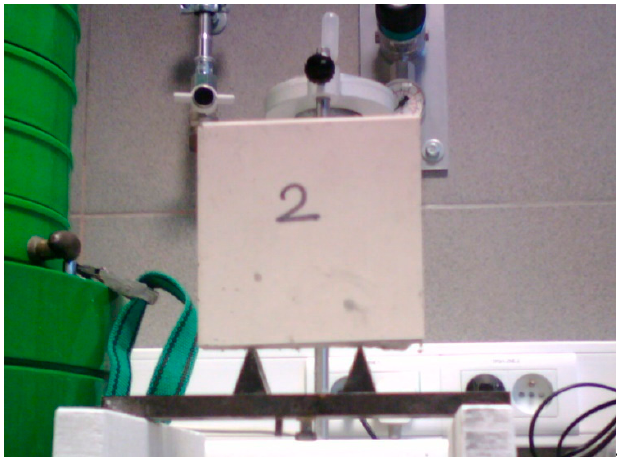
Figure 2. Sample during the thermal imaging